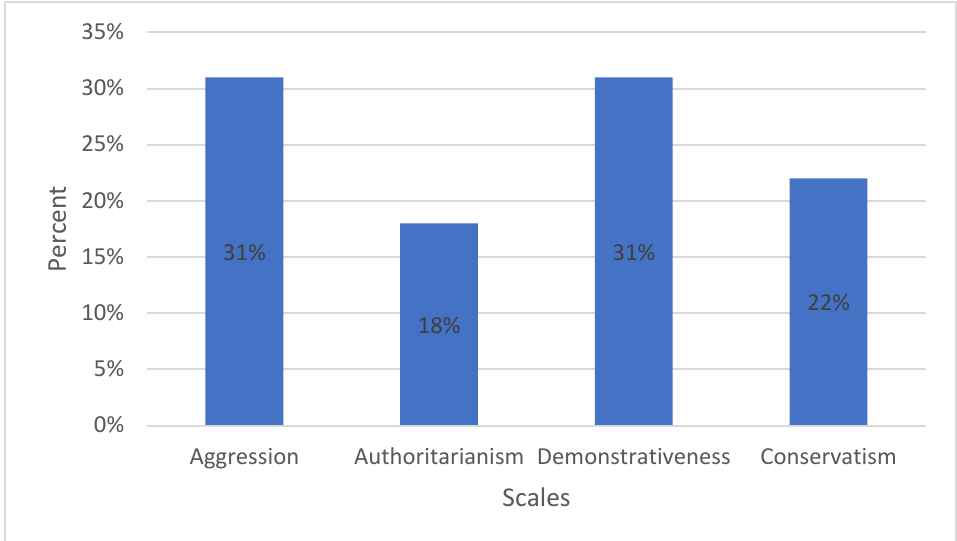
Figure 2. The results of professional deformation.